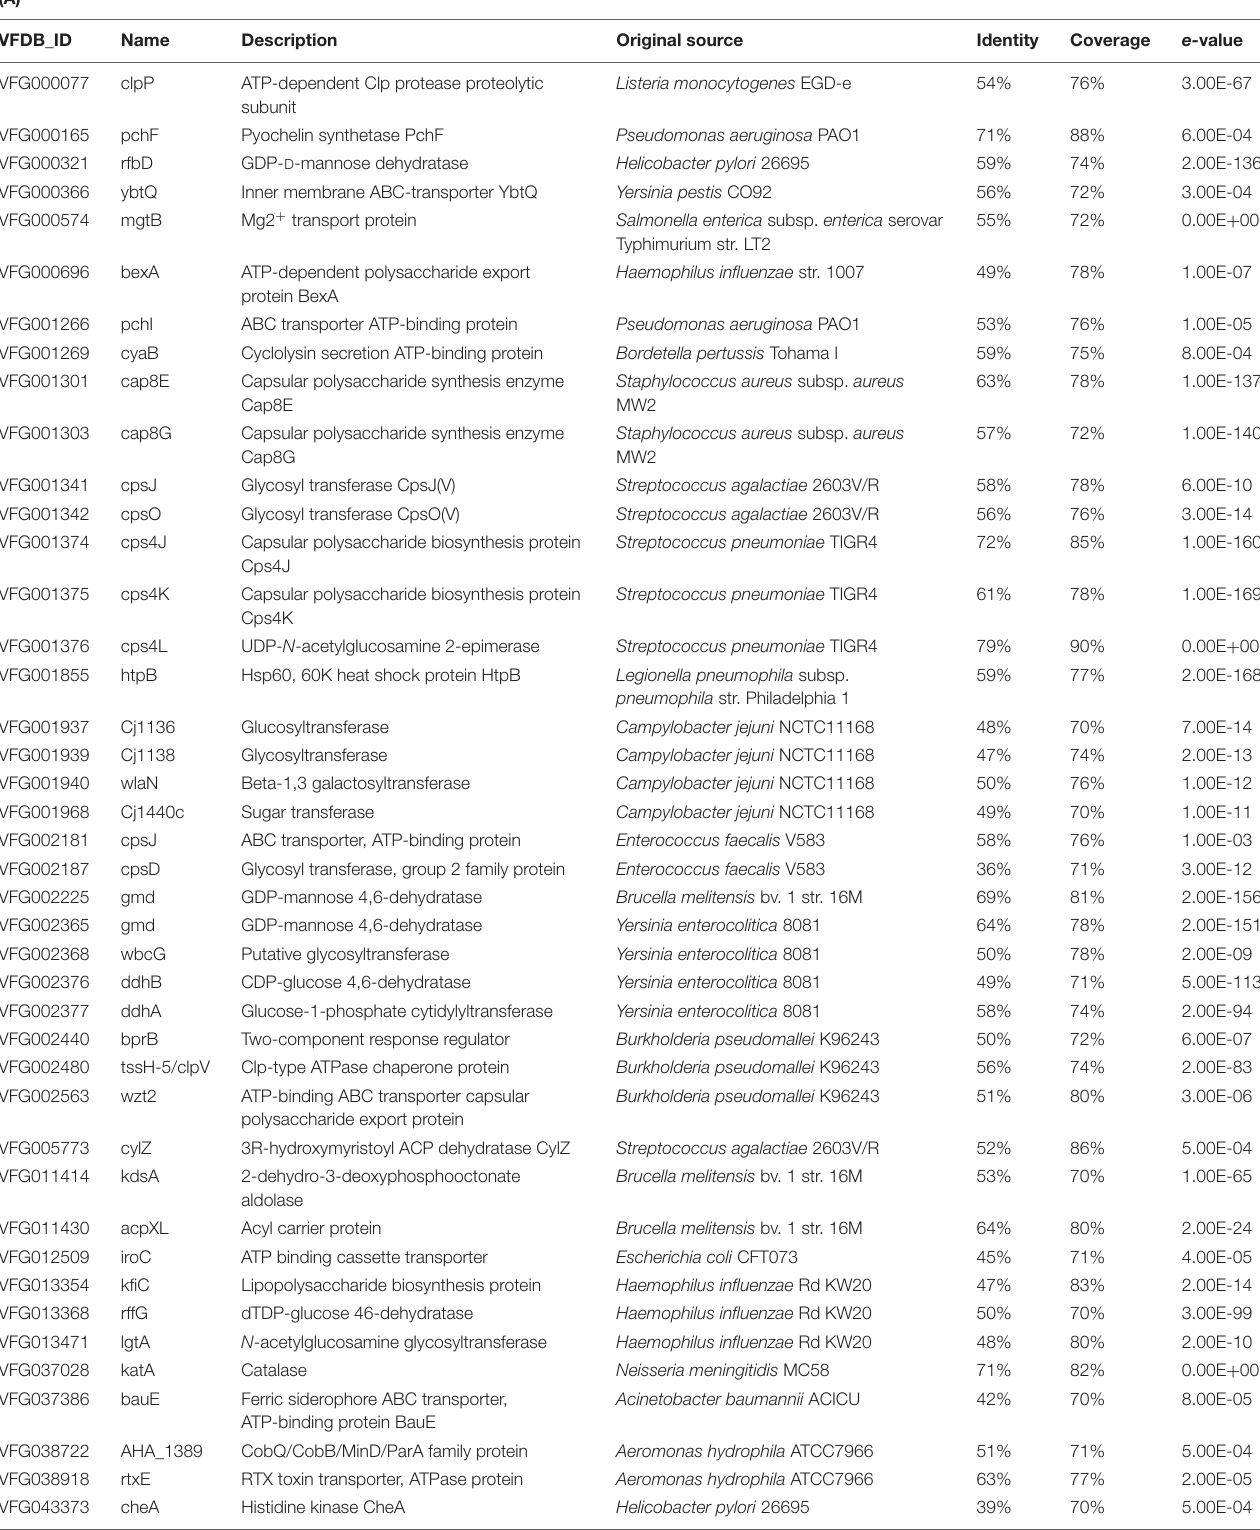
TABLE 1 | (A) Identification of potential virulence factors in the genome of Bacteroides ovatus ELH-B2 according to VFDB database; (B) prediction of putative genomic islands of over 30 kb in the genome of B. ovatus ELH-B2; (C) comparison of Bacteroides -specific virulence genes in B. ovatus ELH-B2 and JCM5824.